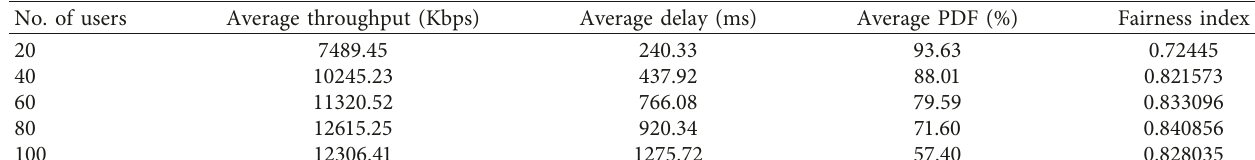
Table 5: Performance of the system for varying number of users in LTE